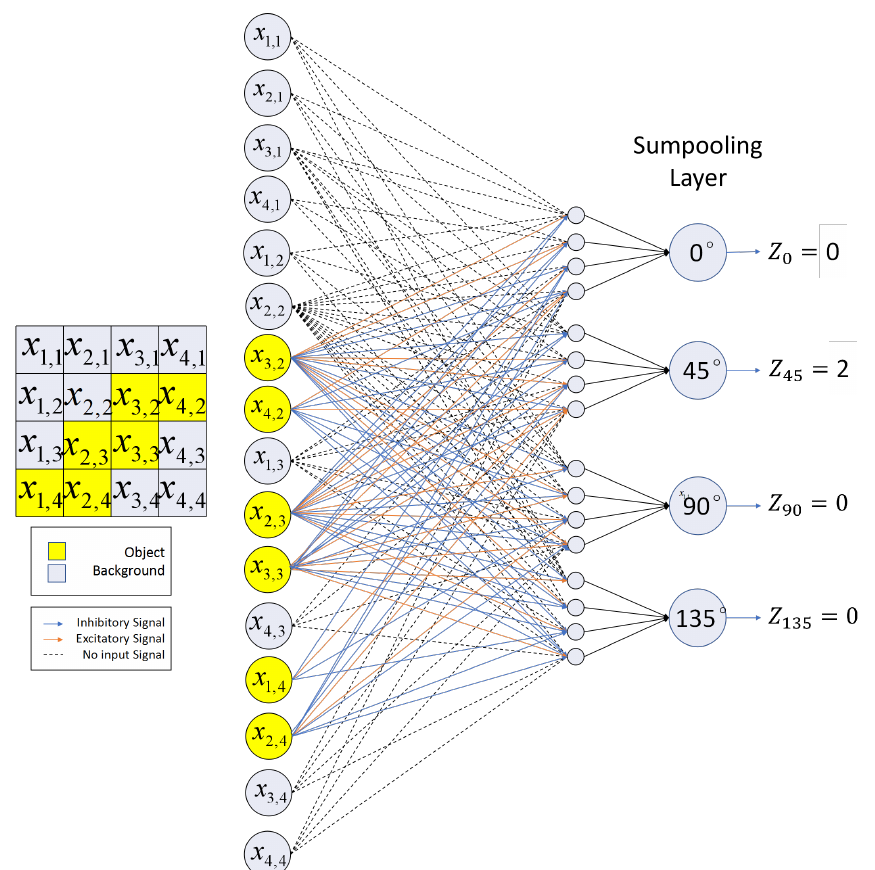
Figure 9. A global orientation detection of an example picture.